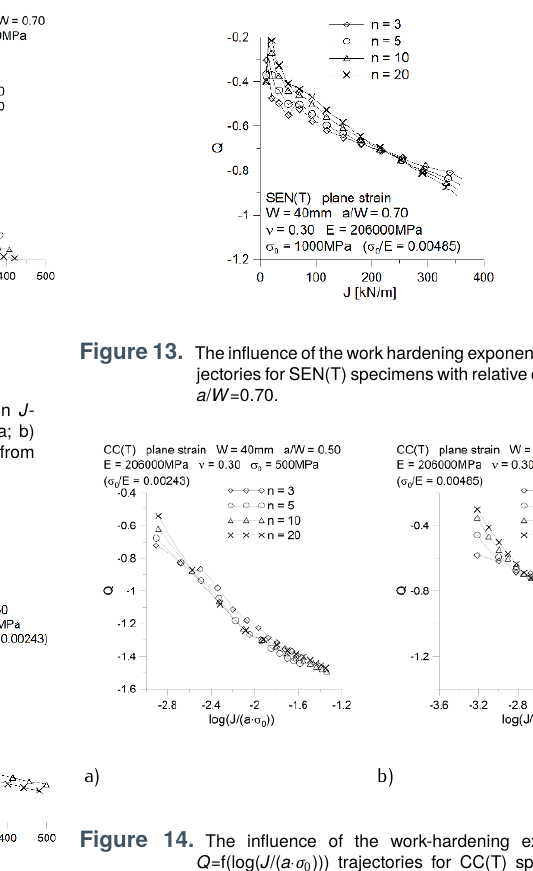
Figure 14. The influence of the work-hardening exponent on Q =f(log( J /( a ·σ 0 ))) trajectories for CC(T) specimen: a) a / W =0.50, σ 0 =500MPa; b) a / W =0.70, σ 0 =1000MPa; which were used in the procedure of